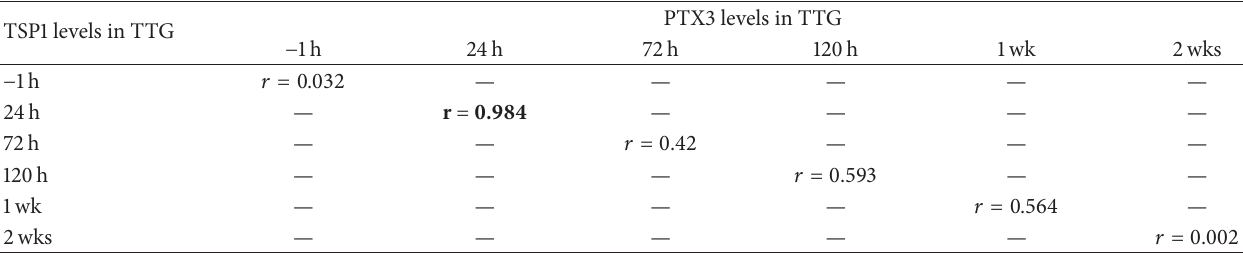
Table 2: Correlations between PTX3 and TSP1 levels at different time points in TTG. For the test groups TTG there were significant positive correlations between levels of PTX3 and TSP1 at 24 hours ( 𝑟 = 0.984 , 𝑝 < 0.05 for TTG) and poor correlations between levels of PTX3 and TSP1 at 72 and 120 hours, 1 week, and 2 weeks (Pearson test for